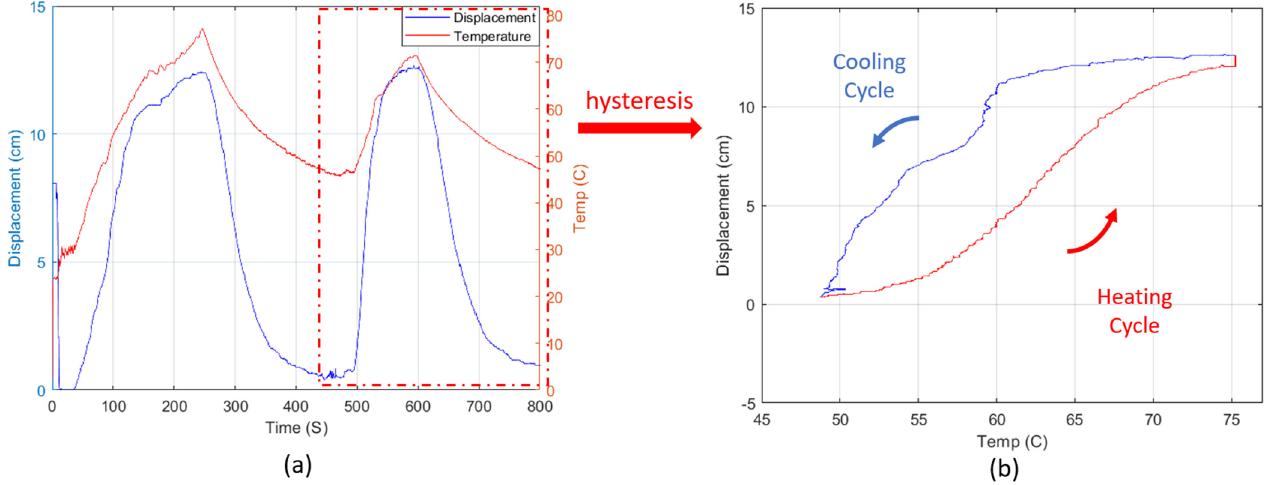
Figure 23. ( a ) Displacement and temperature vs. time; ( b ) displacement vs. temperature (displace- ment hysteresis behavior).